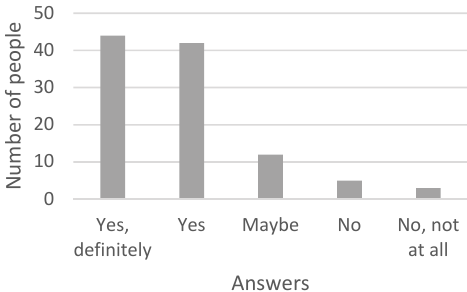
Figure A15. Opinion on the usefulness of knowing what happens after waste collection, first survey (106 individuals).